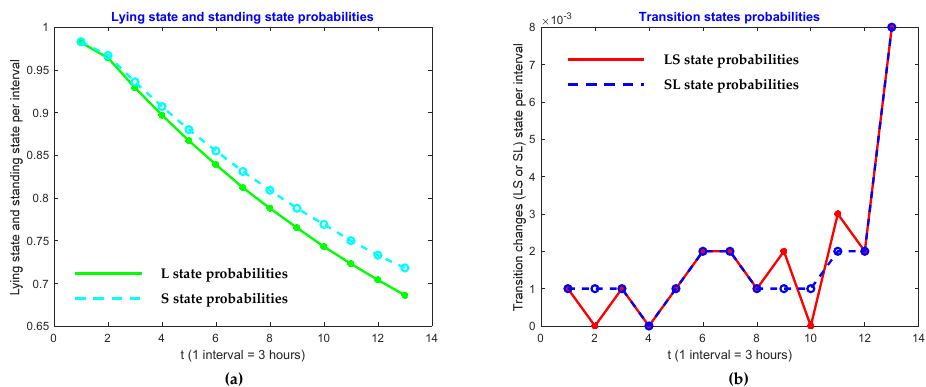
Figure 7. Comparison of ( a ) lying state and ( b ) transition state probabilities of ID 27. Table 3. State probability patterns of ID2, ID11, and ID 27.